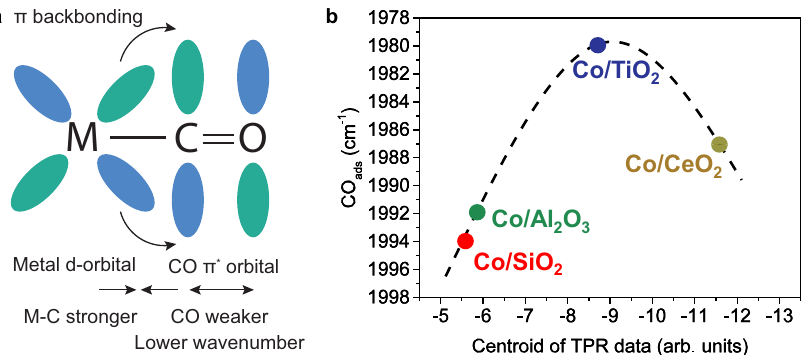
Fig. 3 Support-dependent CO adsorption strengths for the metallic cobalt catalysts. a Schematic drawing of π backbonding when C = O coordinates to a metal center. b Position of linearly adsorbed CO from the phase-resolved amplitude spectra versus the support reducibility, which was determined from H 2 -temperature programmed reduction (TPR) data.